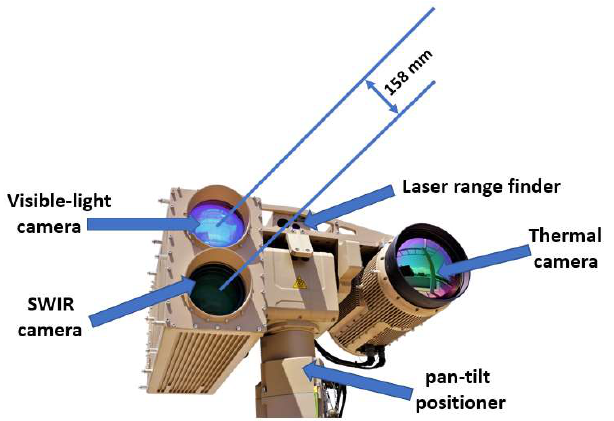
Figure 3. Vlatacom Multi Sensor Imaging System: vMSIS3-CSD-C825-T. Each camera is connected with a Vlatacom Video Signal Processing (vVSP)